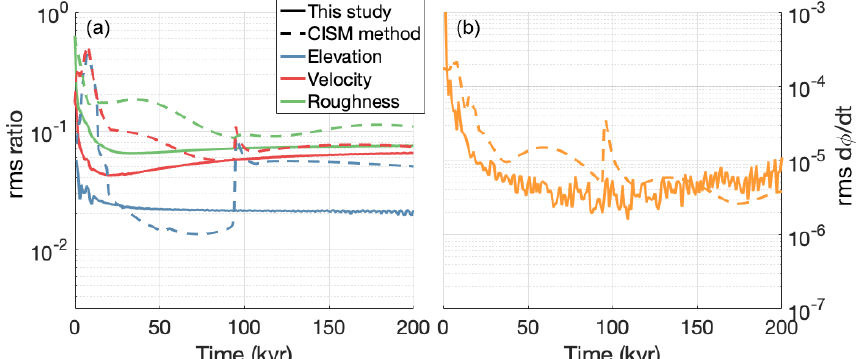
Figure A2. Convergence of the inversion procedure for experiment II. (a) Root mean square of the relative mismatches in surface elevation (blue), surface velocity (red), and bed roughness (green) over time, for both the flowline-averaged method presented here (solid lines) and the local-mismatch approach from CISM (dashed lines). (b) Root mean square of the bed roughness rate of change, for both